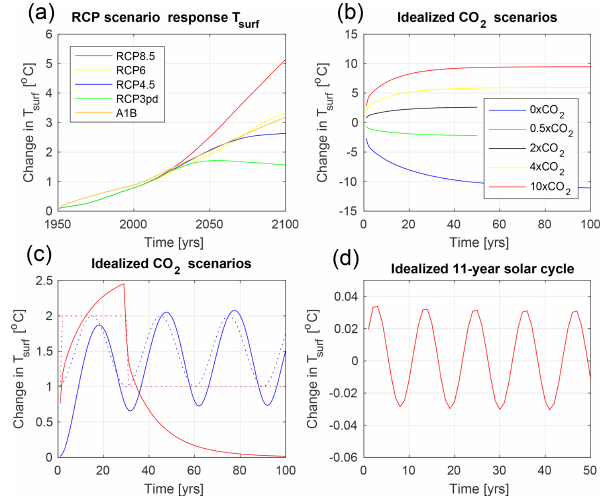
Figure 11. Global mean T surf response to idealized forcing scenar- ios: (a) different RCP CO 2 forcing scenarios. (b) Scaled CO 2 con- centrations. (c) Idealized CO 2 concentration time evolutions (dot- ted lines) and the respective T surf responses (solid lines of the same colour) for the 2 × CO 2 abrupt reverse (red) and the 2 × CO 2 wave (blue) simulations. (d) Idealized 11-year solar cycle. The list of ex- periments is given in Table